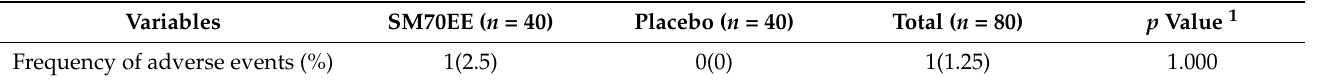
Table 6. Frequency of occurrence of adverse events among the